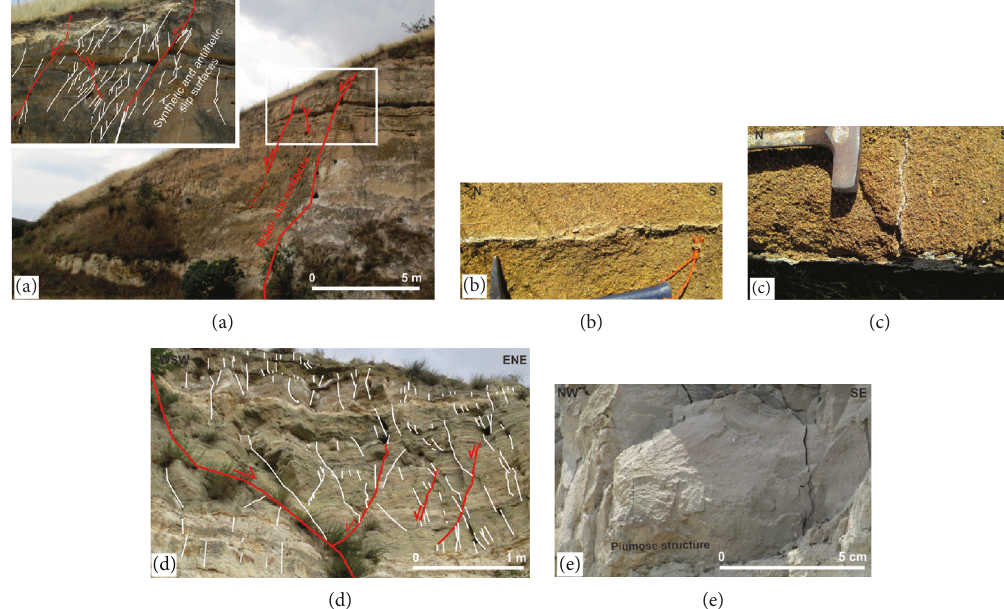
Figure 5: Main structural elements present along the NE-SE fault zone exposed at the Toppo D ’ Aguzzo quarry. (a) Cross-sectional view of the fault zone. Both synthetic and antithetic slip surfaces located at the hanging wall of the main slip surface are reported in the inset. (b) Subvertical N-S striking veins forming an eye structure. (c) High-angle E-W striking vein abutting against a N-S vein. (d) The pyroclastic rocks exposed within the footwall damage zone are crosscut by NE-SW striking fractures localized at the dilational quadrants of sheared parental slip surfaces. See text for further details. (e) Plumose structure displayed along a NW-SE